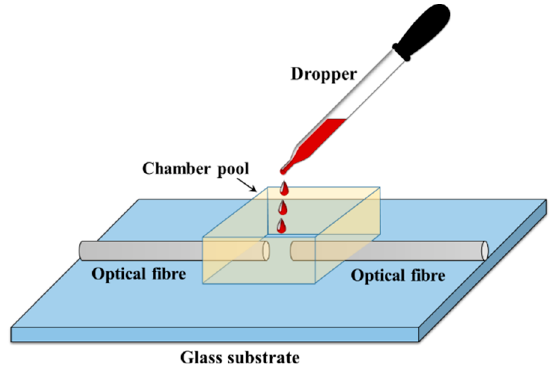
Figure 2. Drop cast photopolymer solution onto the gap between the optical fiber ends.